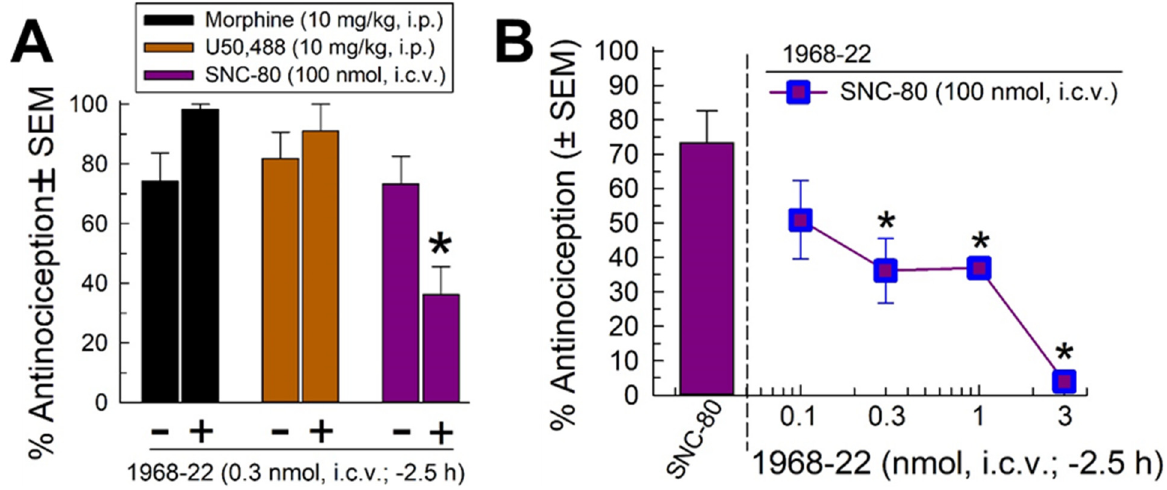
Figure 4. Opioid antagonist activity of 1968-22 in the 55 °C warm-water tail-withdrawal assay. ( A ): Mice were pretreated with 1968-22 (0.3 nmol., i.c.v.) 2 h prior to the administration of the MOR- preferring agonist morphine (10 mg/kg., i.p.), the KOR-selective agonist U50,488 (10 mg/kg., i.p.), or the DOR-selective agonist SNC-30 (100 nmol, i.c.v.) to assess potential antagonism through the re- duction of the antinociceptive effect of the opioid agonist. ( B ): 1968-22 dose-dependently antago- nizes SNC-80. Mean % antinociception ± SEM from eight mice for each bar. * significantly different from response of agonist alone ( p < 0.05); ( A ) two-way ANOVA or ( B ) one-way ANOVA with ( A ) Tukey’s or ( B ) Dunnett’s multiple comparison post hoc test.